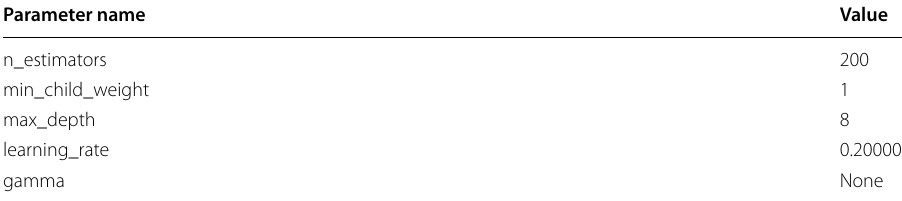
Table 104 Modes of XGBoost tuned hyperparameter values for experiments with the keylogging